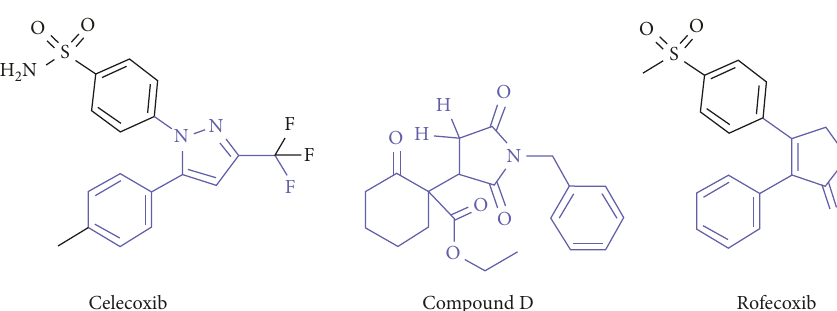
Figure 1: Rationale of the COX-2 inhibitors celecoxib and rofecoxib with our compounds (compound D